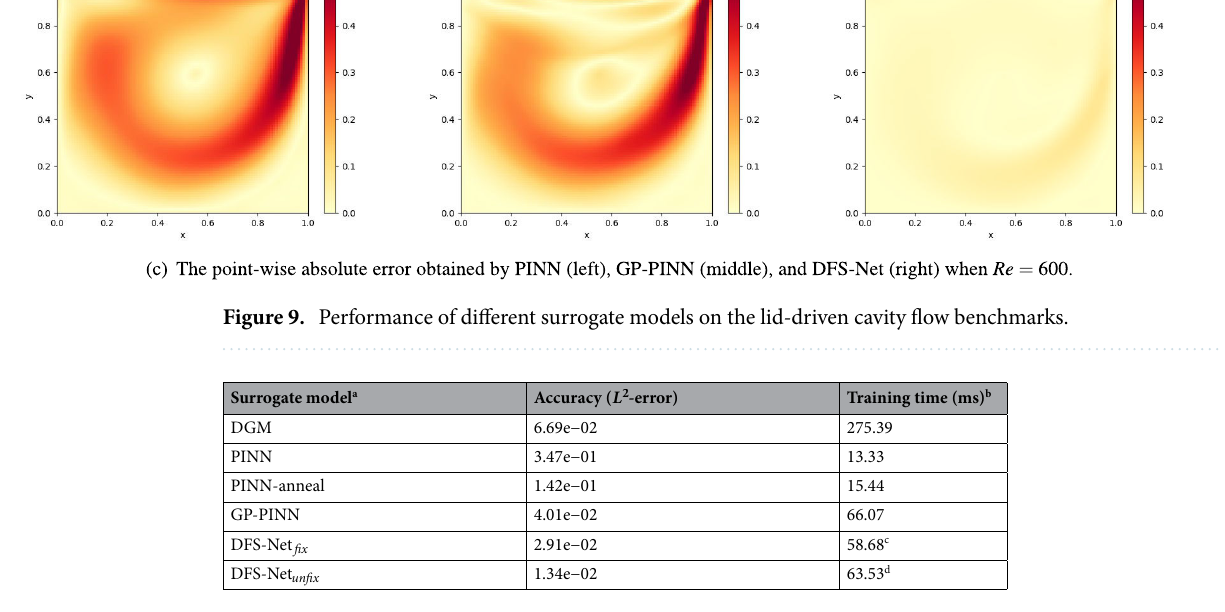
Table 4. Comparison of the relative L 2 -error of different neural network-based surrogate models on the lid- driven cavity flow benchmark ( Re = 100 ). a All models consists of three hidden layers with 50 neurons in each layer. b The training time for each Adam epoch. c The training time of DFS-Net fix for each L-BFGS-B epoch